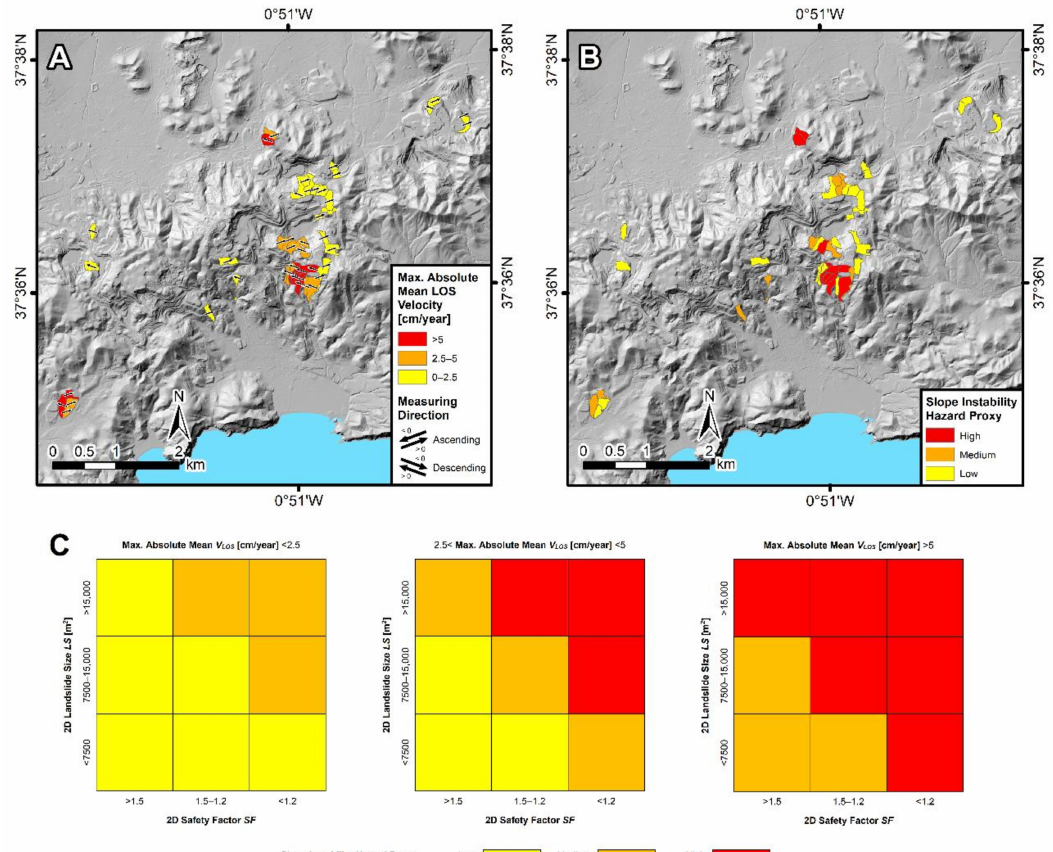
Figure 12. ( A ) Maximum absolute mean LOS ground velocities for the 43 active deformation slope units (ADSUs) from the optimal set (ADSU set 18). Directions of movement are also indicated. ( B ) Slope instability hazard proxy obtained through the combination of the 2D landslide size LS (as a proxy for magnitude of failure), the LOS ground velocity V LOS (as a proxy for frequency of failure), and the 2D safety factor SF (as a proxy for susceptibility of failure) for each ADSU. ( C ) Matrix defined to evaluate the slope instability hazard